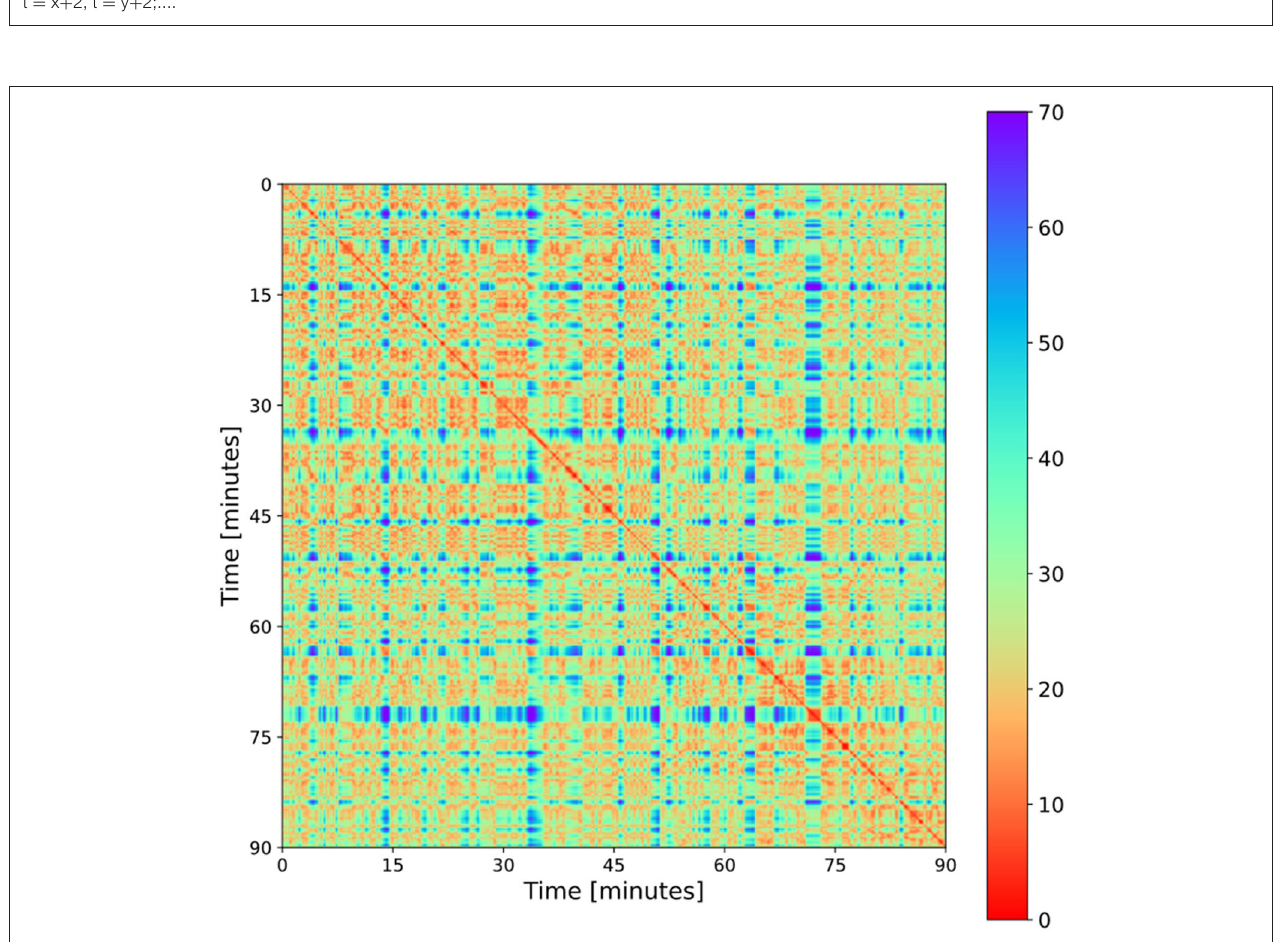
FIGURE 2 | An RP of a football match (game 05). Typical features are the red diagonal stripe, blue/turquoise stripes or bands and rectangles or blocks containing red/orange spots embedded in green (explanations are given in the text).